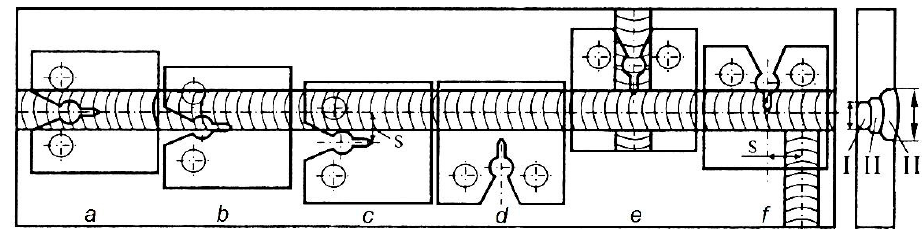
Figure 14. Scheme of cutting out samples that guarantees the spread of main fractures along the material of the welded joint ( a , e ), heat-affected zone ( b , f ) and core material ( c , d ); I, II, III—number of zones of a welded joint; s—distance from the axis of the seam to the notch [35–40].